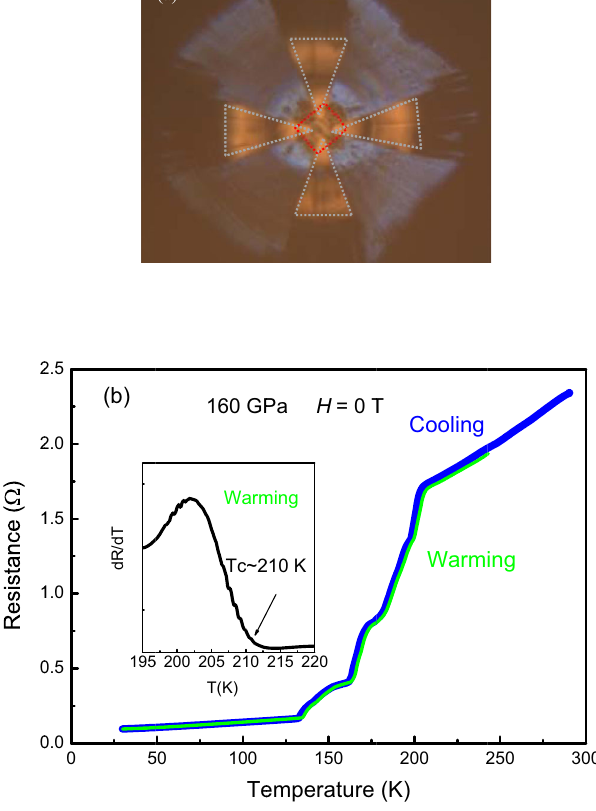
Fig. 1 The superconductivity measurements. a The image of the specimen assembly. b The temperature dependence of resistance R ( T ) measured at 160 GPa and zero magnetic fi eld for Sample A. The multiple steps in the transition region imply there might be phases with different hydrogen amount in the synthesized calcium superhydrides. The inset is the enlarged view of the derivative of resistance over temperature(d R /dT) where the ~210 K T c onset is determined referring to the upturn point at the right side.